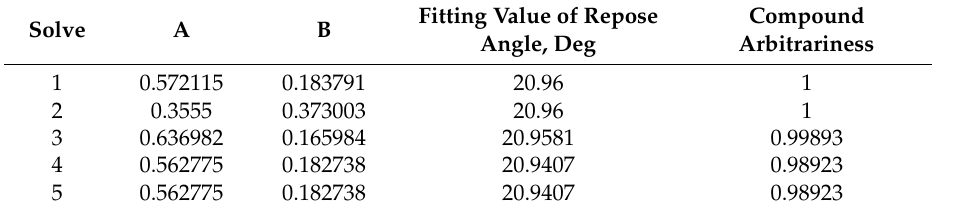
Table 8. Parameter optimization results of ZD39.